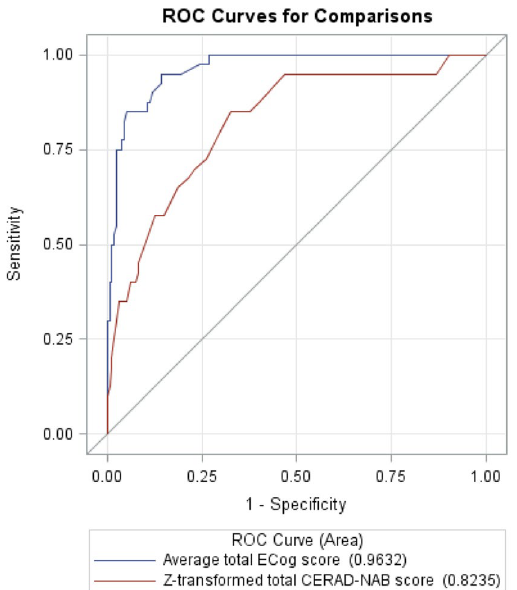
Figure 2. ROC curves of z-transformed total CERAD-NAB score and average total ECog score. The ROC curves were tested for the ability to discriminate between normally aging adults and patients with early stage probable AD. The AUC associated with the average total ECog scores was significantly higher than that associated with the z-transformed total CERAD-NAB score (AUC = 0.96, 95% CI = 0.94–0.99, sensitivity = 0.95, specificity = 0.86, cutoff point = 1.23; AUC = 0.82, 95% CI = 0.75–0.90, sensitivity = 0.85, specificity = 0.68, cutoff point = − 1.01, respectively; P < 0.01).